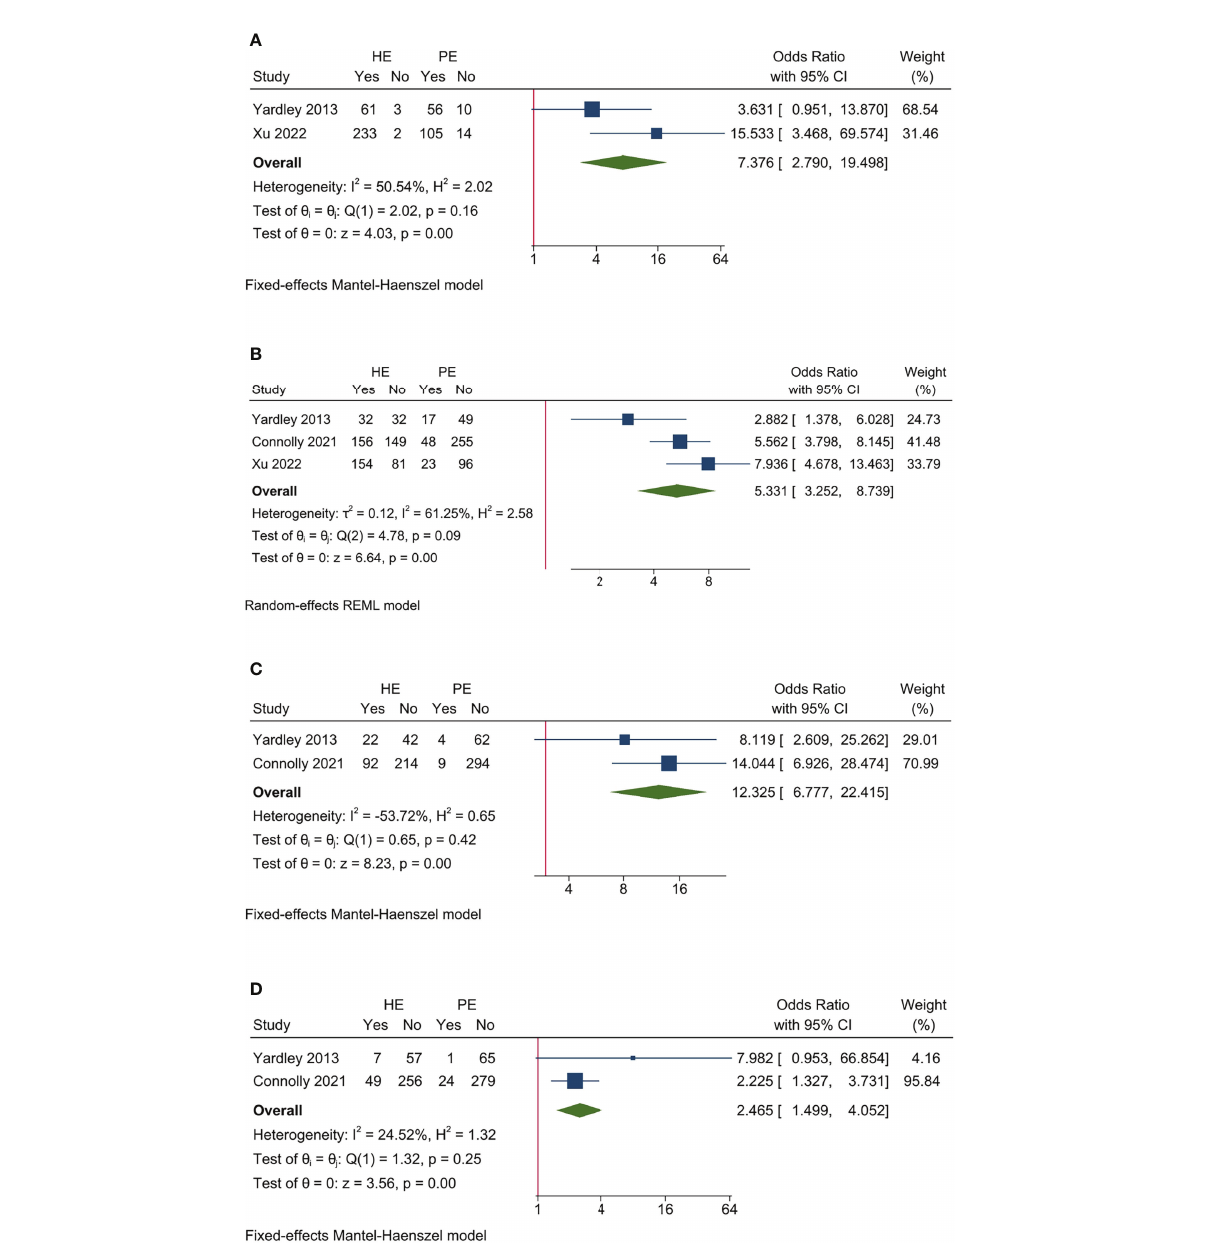
FIGURE 6 | Sensitivity analysis for AE endpoints of studies on entinostat. (A) All AE; (B) Grade ≥ 3 AE; (C) dose modi fi cation due to AE; (D) treatment discontinuation due to